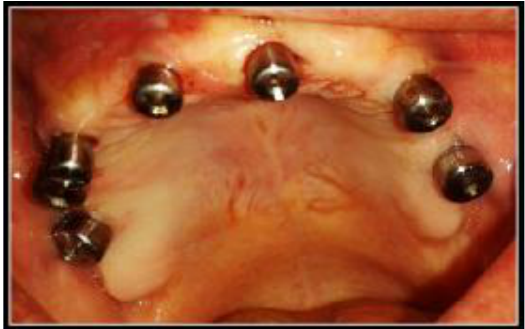
Figure 9: Healing Abutments in the 2 nd Stage Surgery.